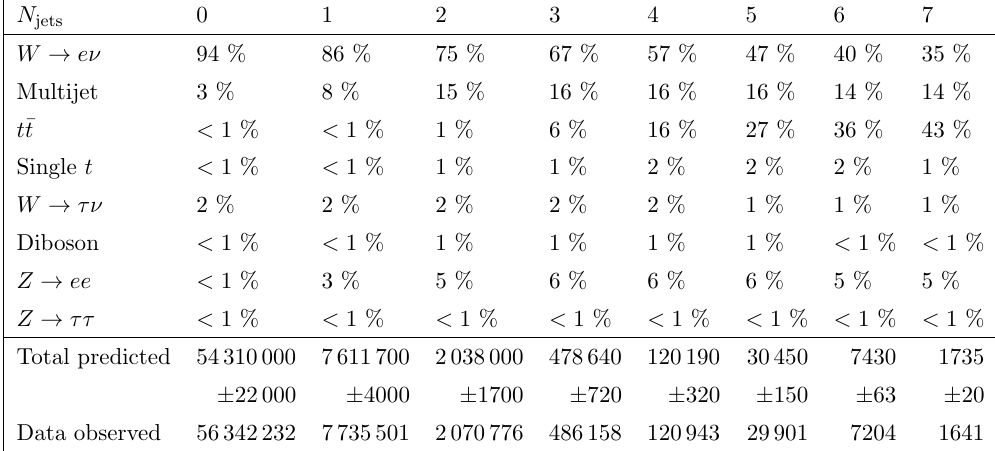
Table 1 . Signal and background contributions in the signal region for di(cid:11)erent jet multiplicities as percentages of the total number of predicted events, as well as the total numbers of predicted and observed events. The uncertainty in the total predicted number of events is statistical